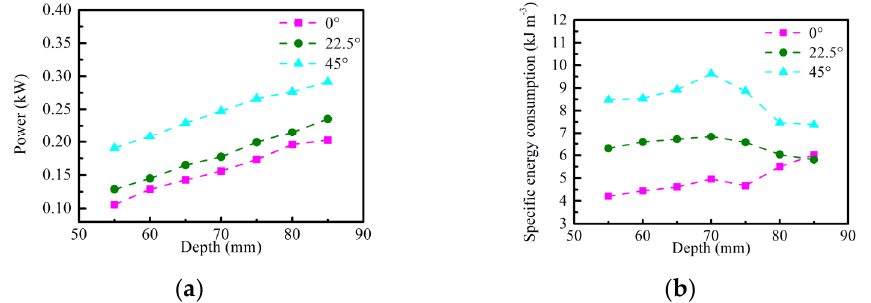
Figure 7. Effect of operating depth on power and specific energy consumption. ( a ) Effect of operating speed on power; ( b ) effect of operating depth on specific energy consumption.